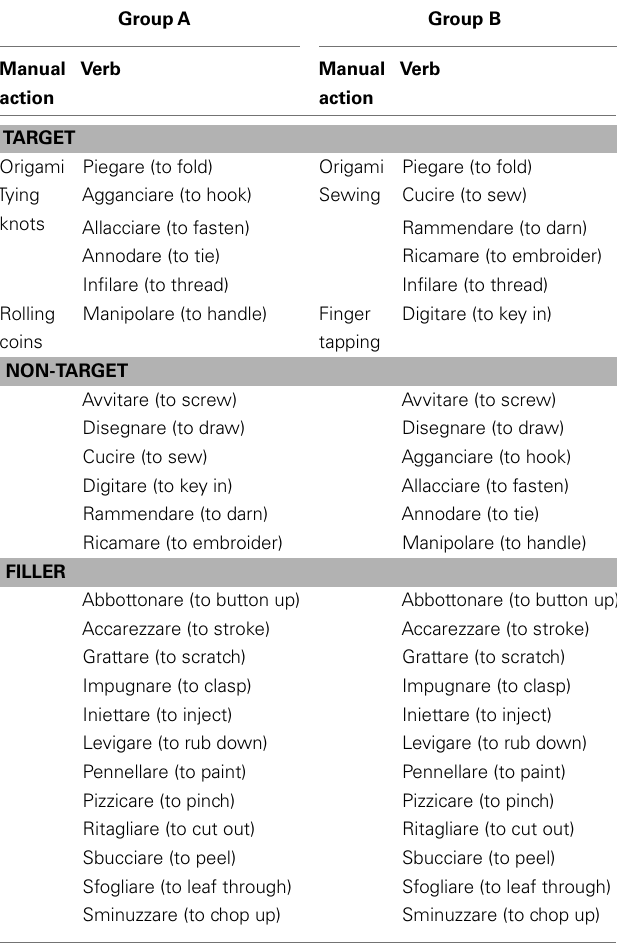
Table 1 | List of Italian verbs and English